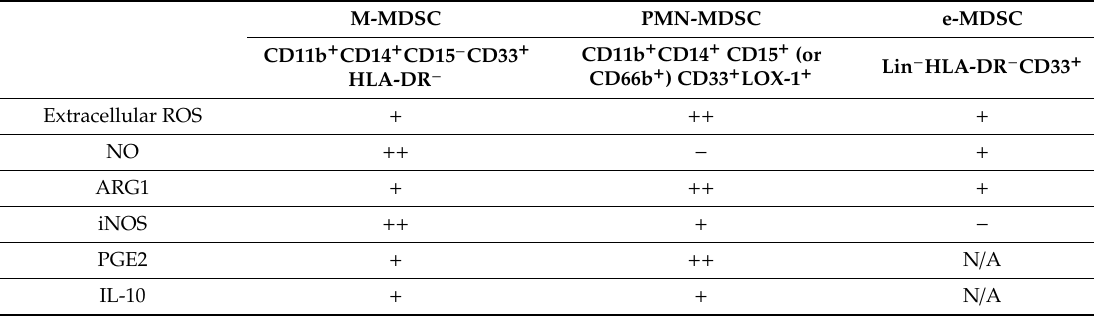
Table 2. Common molecules and functions of MDSCs in